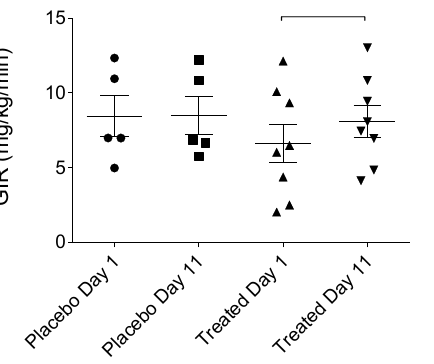
Figure 3. GIR in the placebo- and fenugreek-treated subjects. ** refers to statistically significant difference ( p < 0.01) between Day 1 and Day 11 in the treated group.